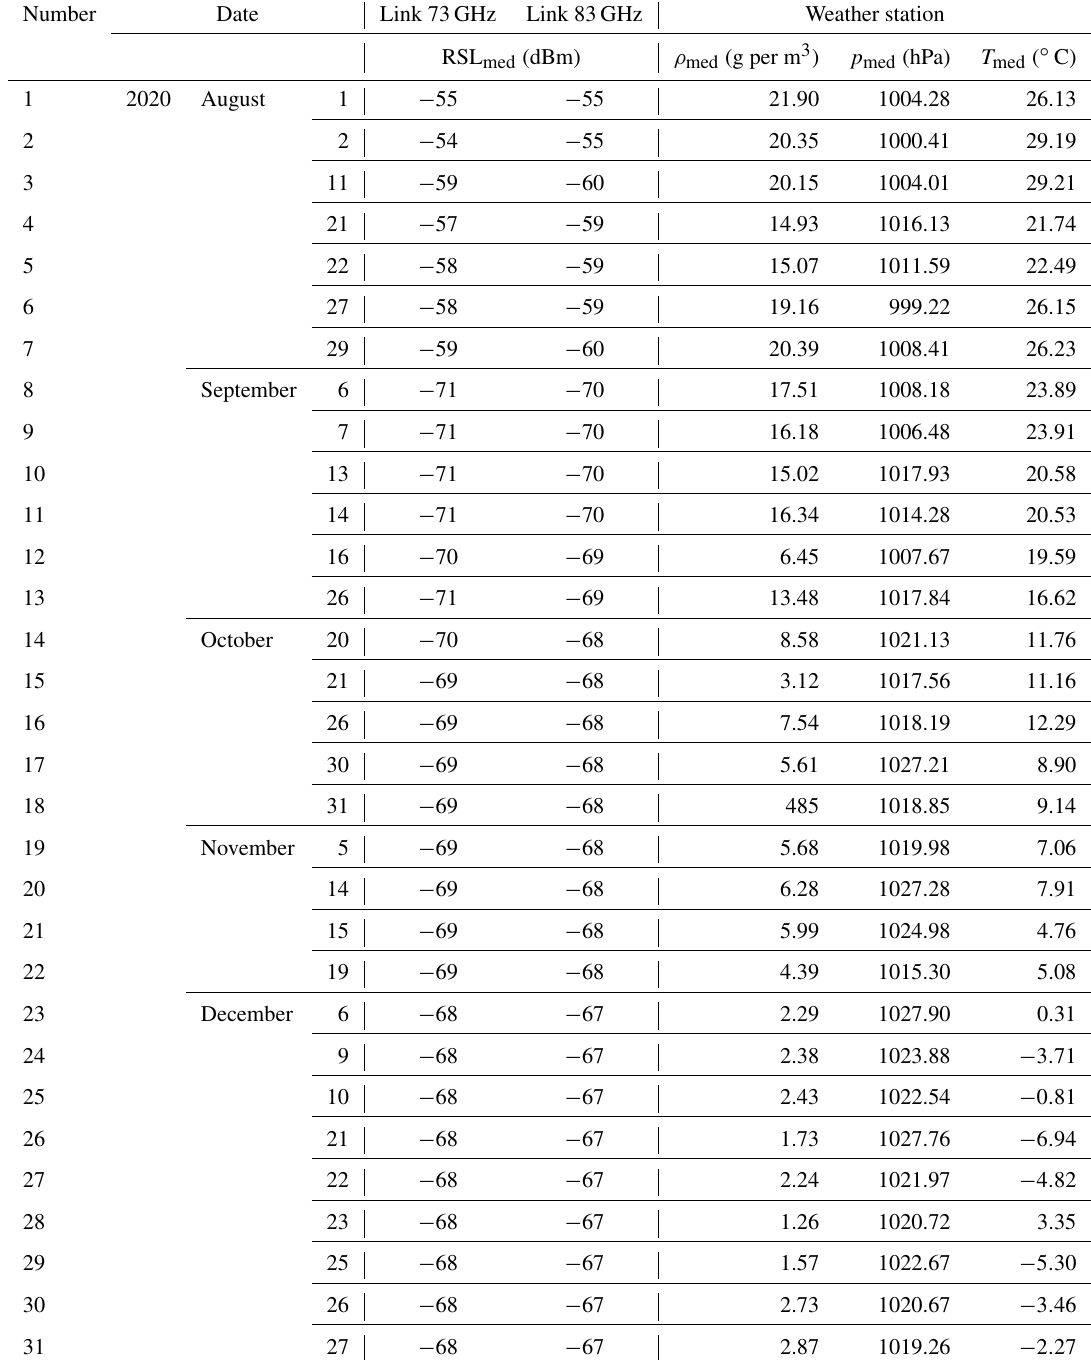
Table 1. Daily variation statistics of the E-band millimeter wave link receiving signal level and weather station